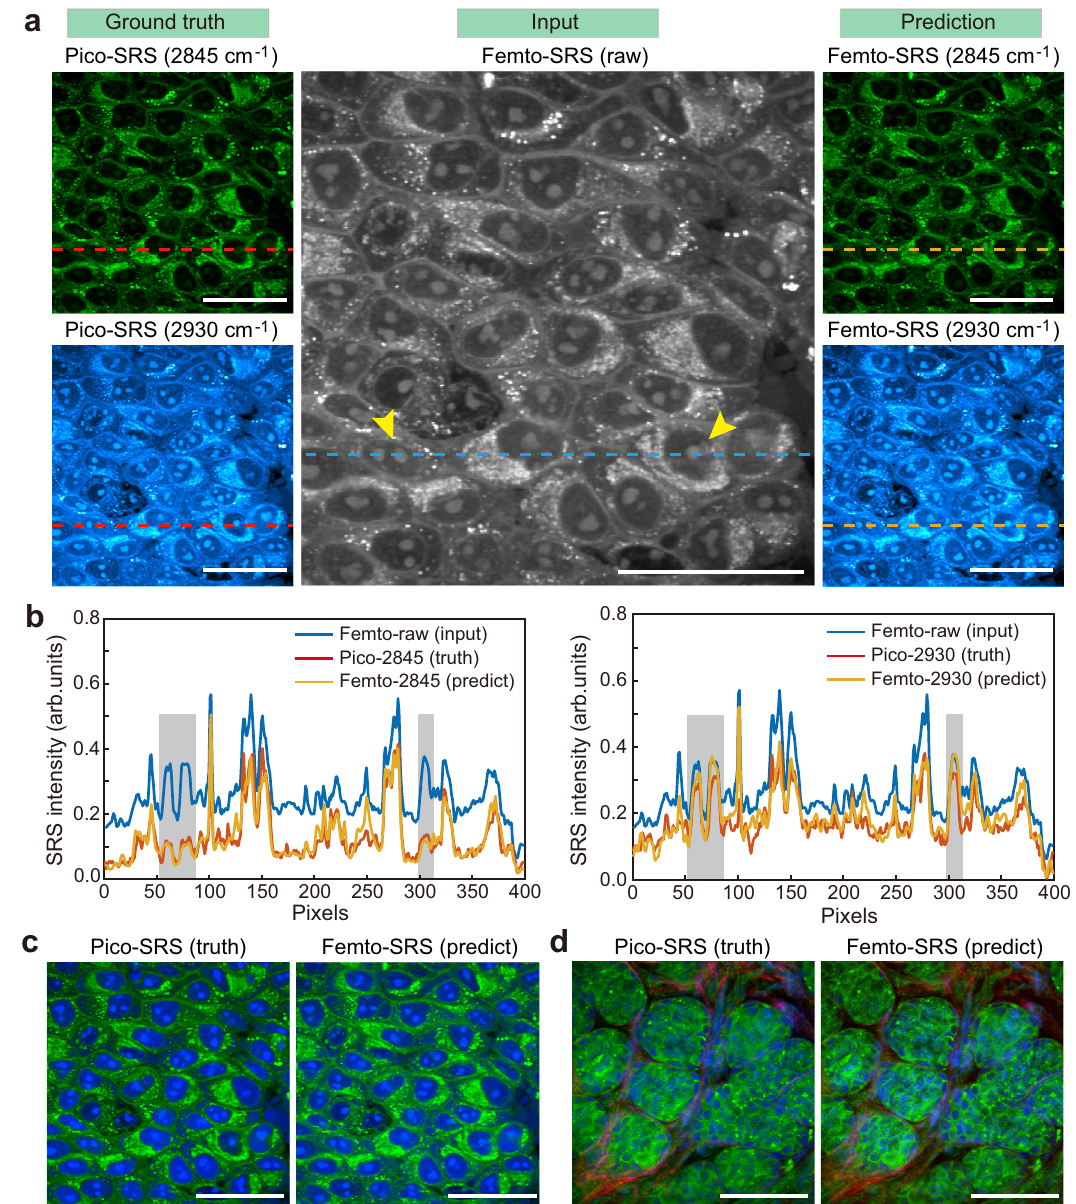
Fig. 2 Deep U-Net based femto-SRS imaging with recovered chemical resolution. a Single raw femto-SRS image (middle) was converted by U-Net into the spectrally resolved images at 2845 cm − 1 and 2930 cm − 1 (right), compared with the ground truth pico-SRS images (left). b Intensity pro fi les (dashed lines in ( a )) of the predicted and ground-truth data, showing chemical contrast in the cell nucleus regions (shadows, and arrows in ( a )). c , d Femto-SRS imaging of live cells and gastric tissues, yielding almost identical results to pico-SRS. Green: lipids; blue: protein; red: collagen fi bers. Scale bars: 50 µ m. Source data are provided in the Source data fi